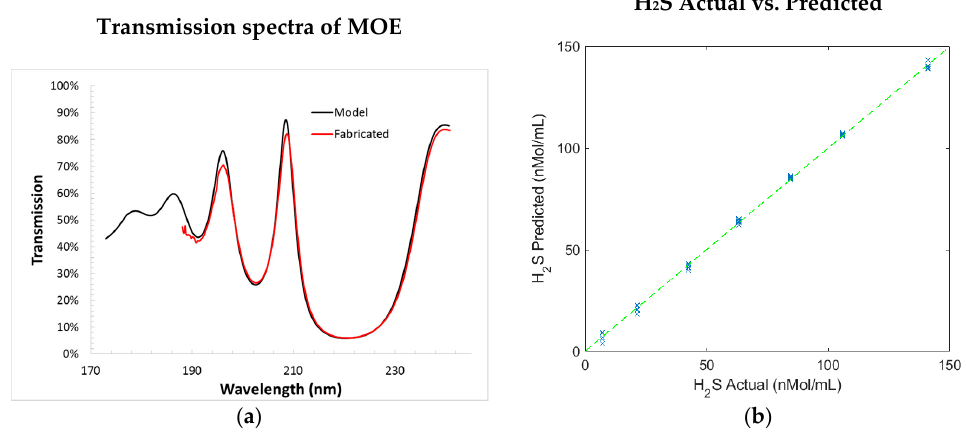
Figure 7. ( a ) Comparison of the simulated spectrum of the designed MOE and the measured spectrum of the fabricated MOE, two spectra match very well; ( b ) the expected calibration performance of the fabricated